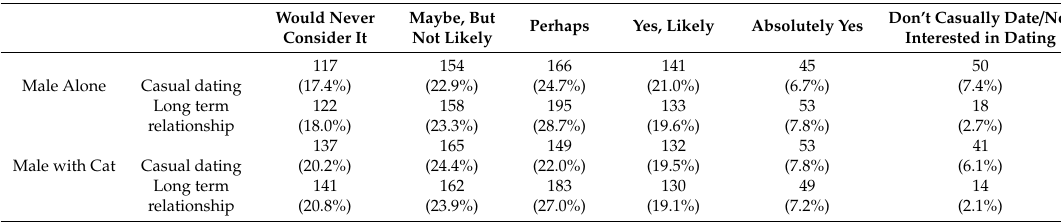
Table 6. Survey / Male 2